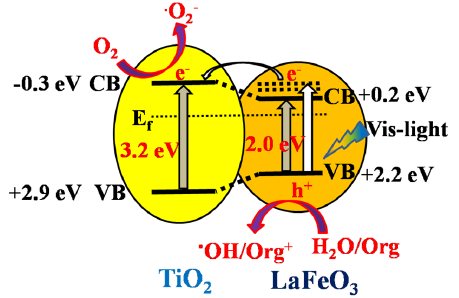
Figure 7. Scheme for energy band gaps and the mechanism for photogenerated charge separation and transfer in the fabricated T/P-LFO